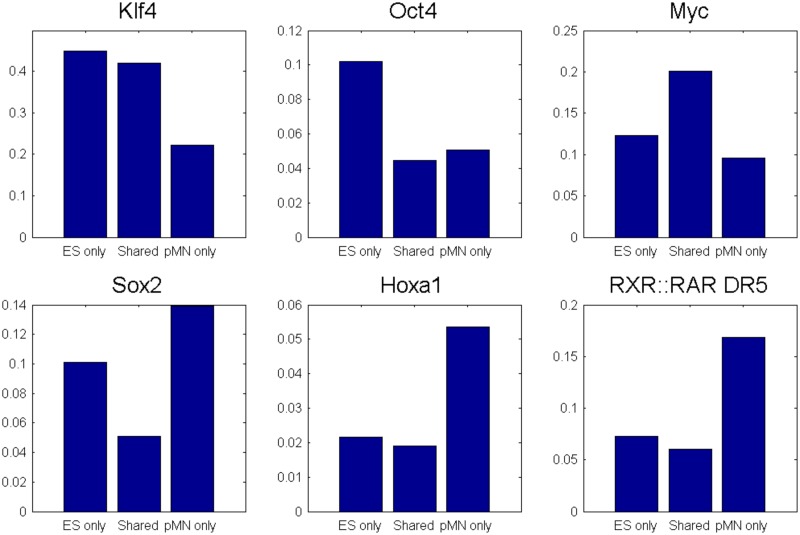
Enhancer usage reflects cell-type appropriate motif enrichment.1 kb windows centered on Med1 binding events involved in interactions with TSSs in one or both cell types were scanned for matches to known transcription factor motifs. Med1 binding events were categorized based on whether they interact with TSSs in one or both cell types. The bar graphs reflect the percentages of Med1 binding events in each group that have a motif match within 500 bp for several important transcription factors.